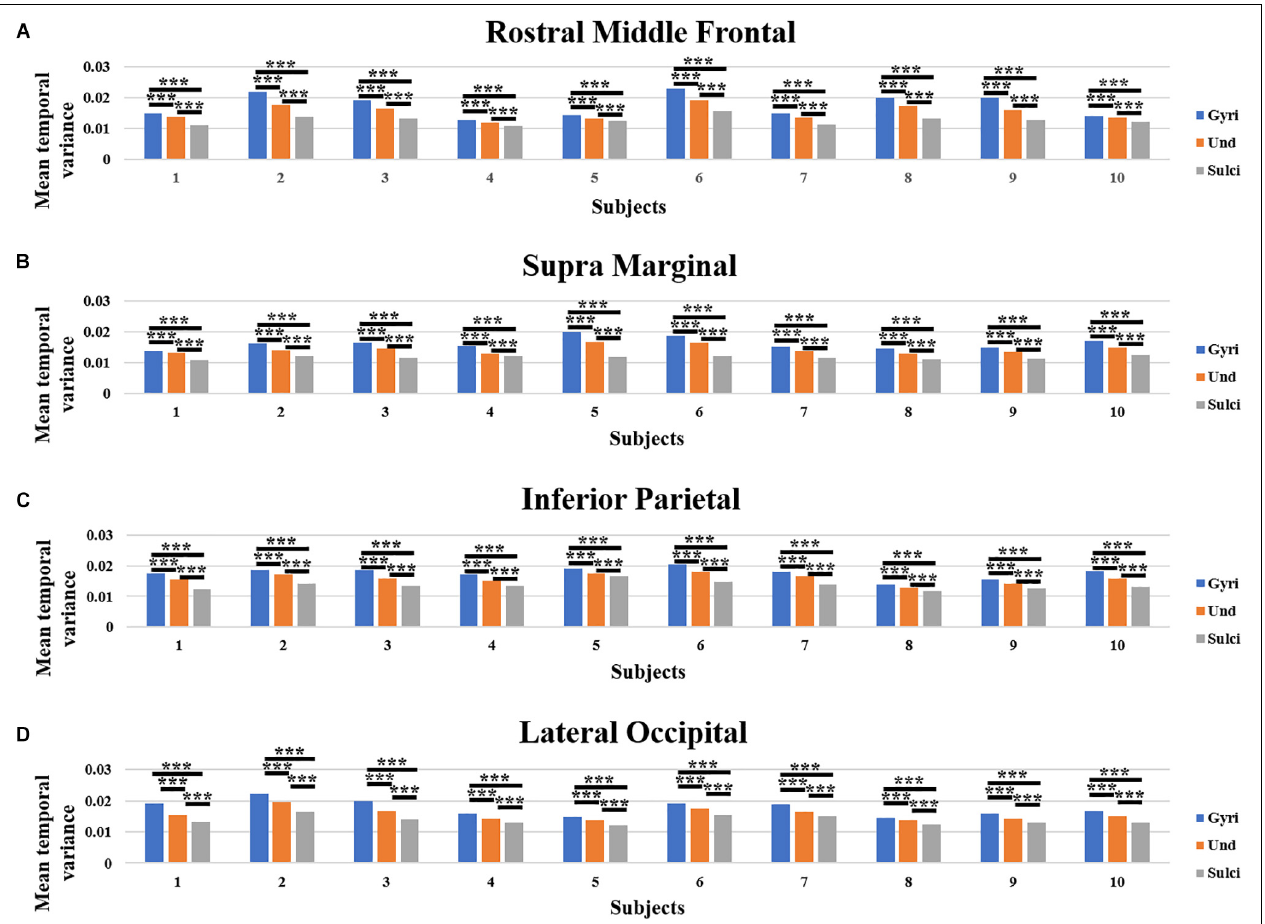
FIGURE 4 | Mean temporal variance difference of functional activity among gyri, sulci, and undefined regions in ROI-scale in ten subjects. (A–D) The mean temporal variance of gyri, sulci, and undefined regions in ten subjects within each of the four ROIs, respectively. ∗∗∗ Indicates p < 0.001.